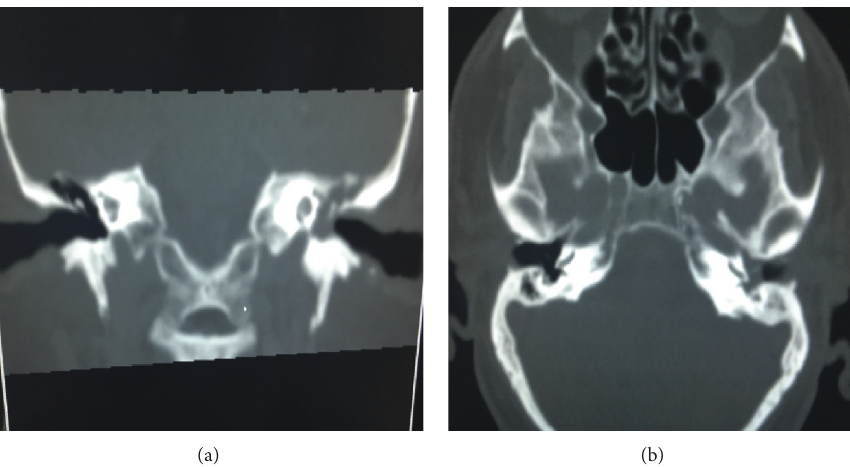
Figure 1: CT scan of temporal bone showing features of tympanomastoiditis and soft tissue shadow involving the middle ear and attic areas. (a) Coronal. (b) Axial.